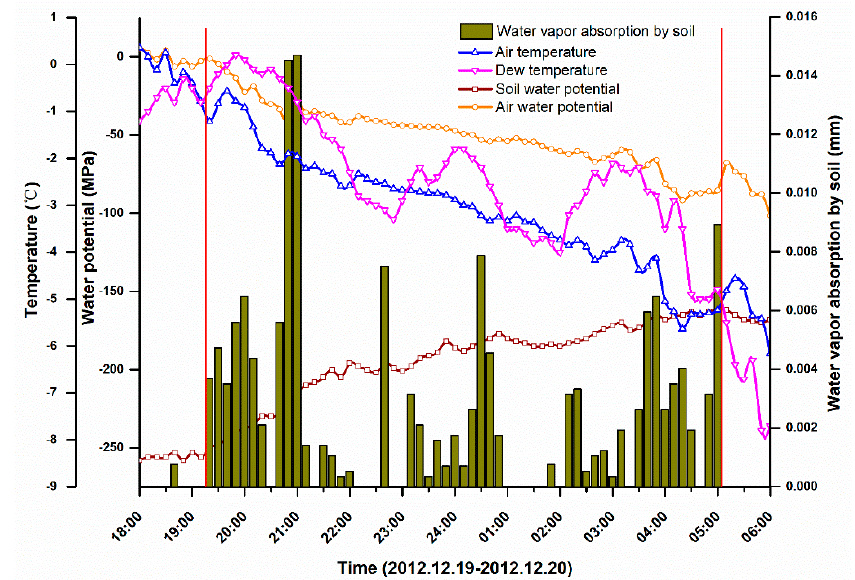
Figure 11. Changes of water vapor absorption by soil vs. different kinds of water potential on a typical night (including air and soil water potential; 19–20 December 2012).